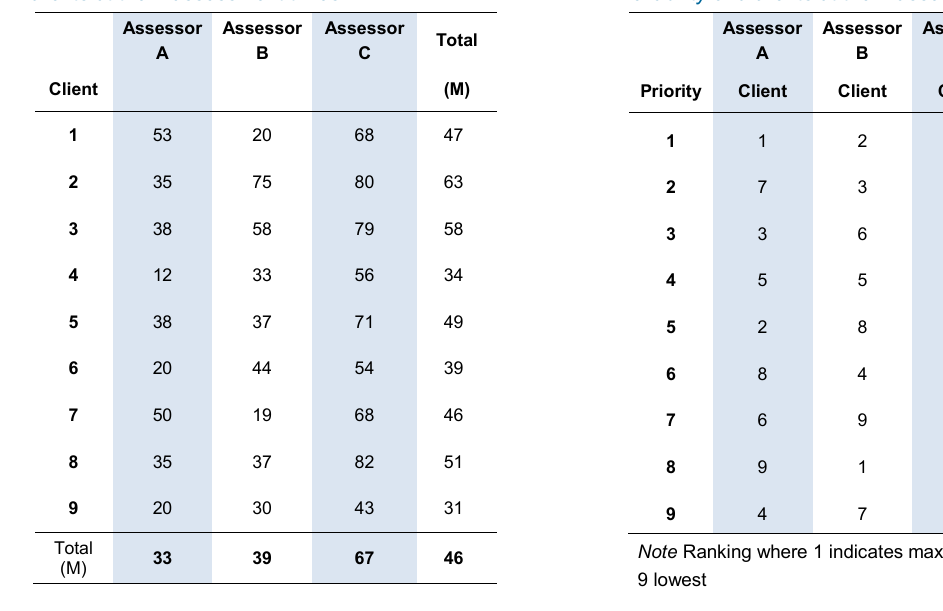
Table 8a: Percentage of intra-assessor reliability of 9 Table 8b: Ranking of the percentage of intra-assessor